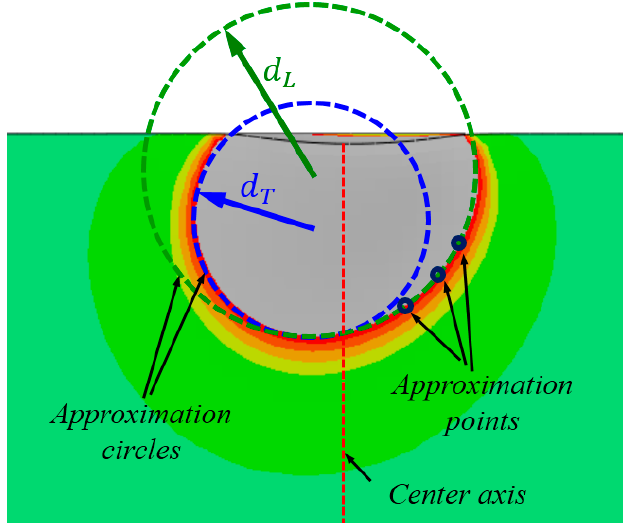
Figure 6. Description of the bottom shape of the out-of-plane deformation contour using two circles.